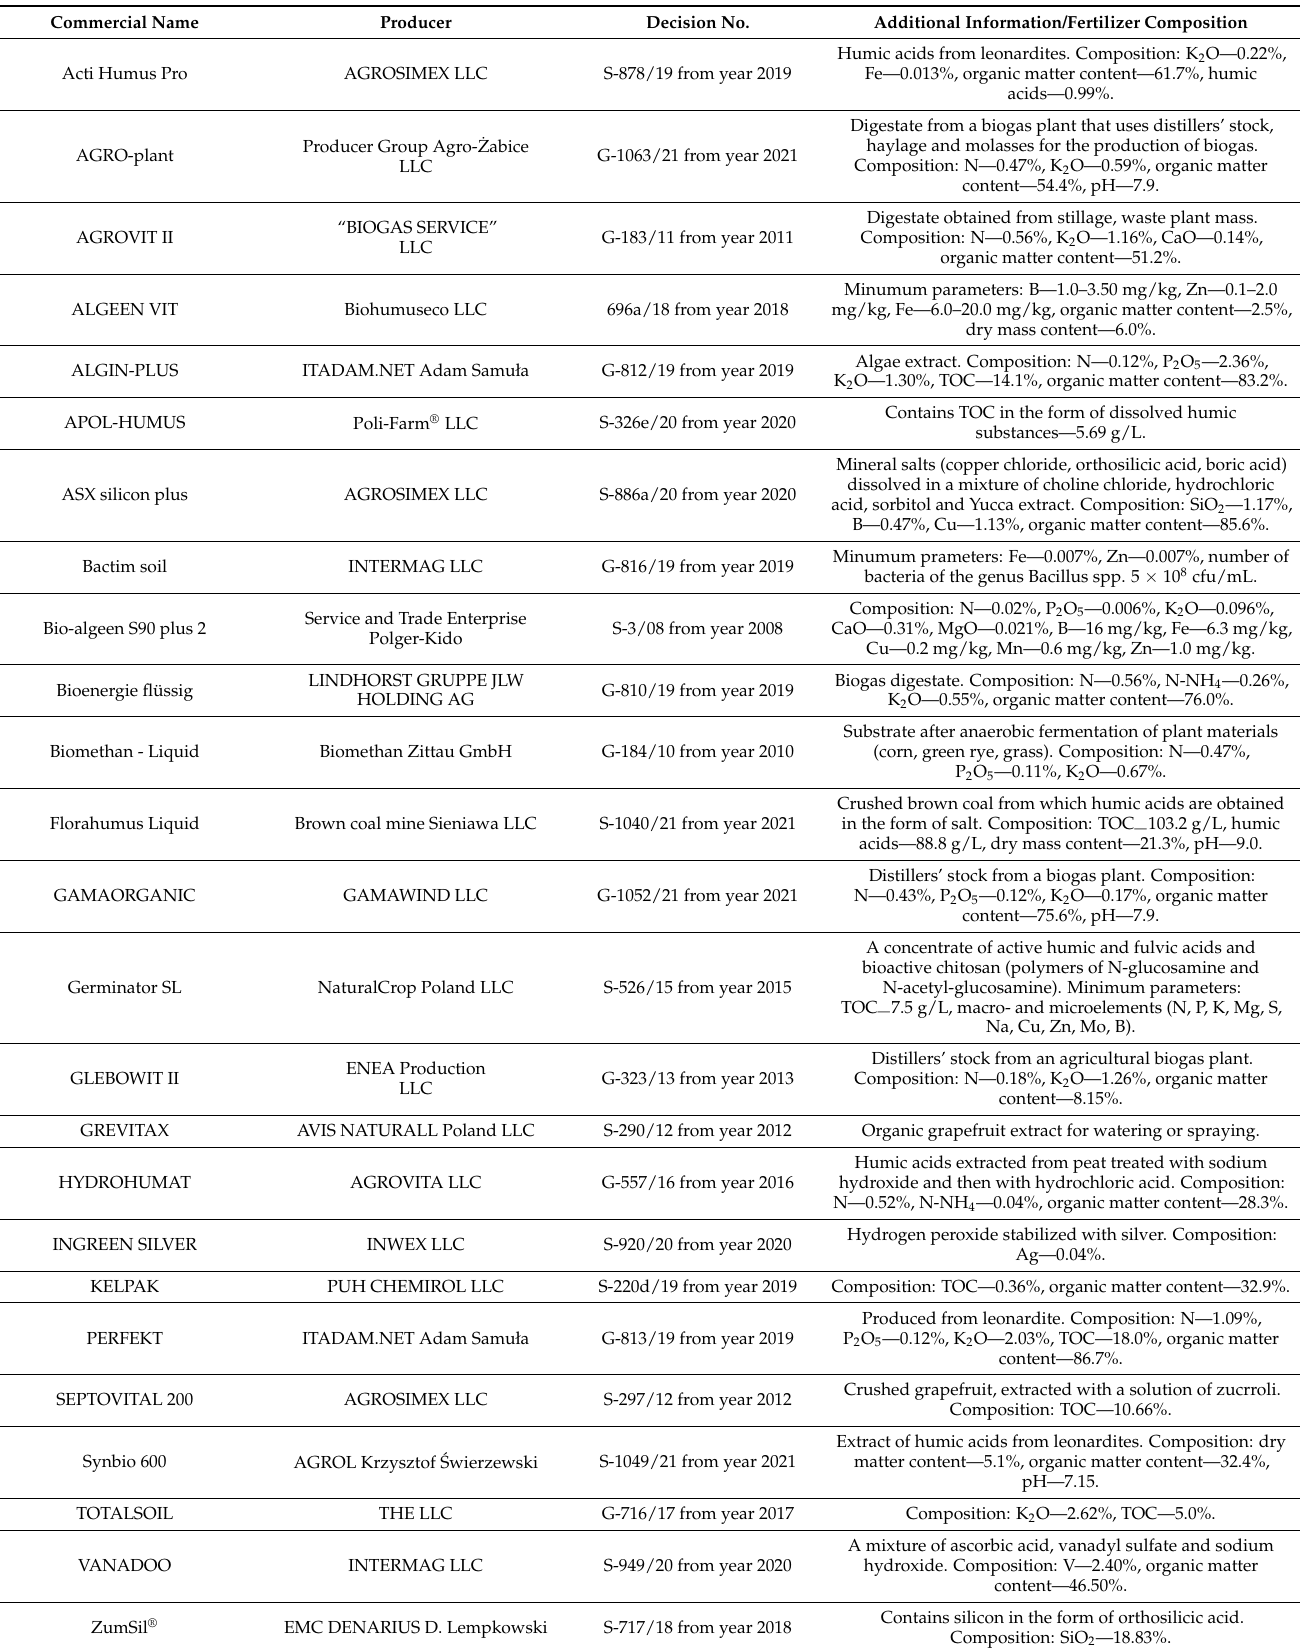
Table 10. Selected soil conditioners in liquid form (authors’ own elaboration based on